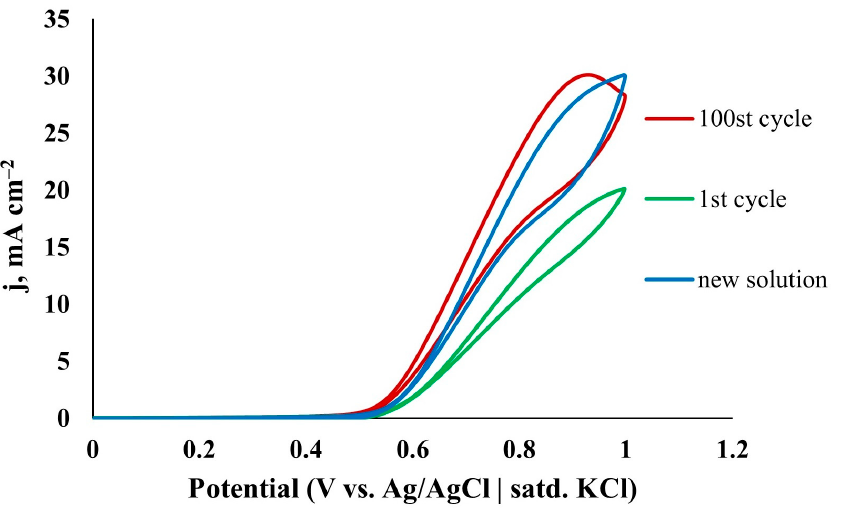
Figure 2. Multi-CV scans up to the 100th cycle in an alkaline solution of 0.1 M NaOH and 0.5 M C 2 H 5 OH in the ethanol oxidation on a modified copper